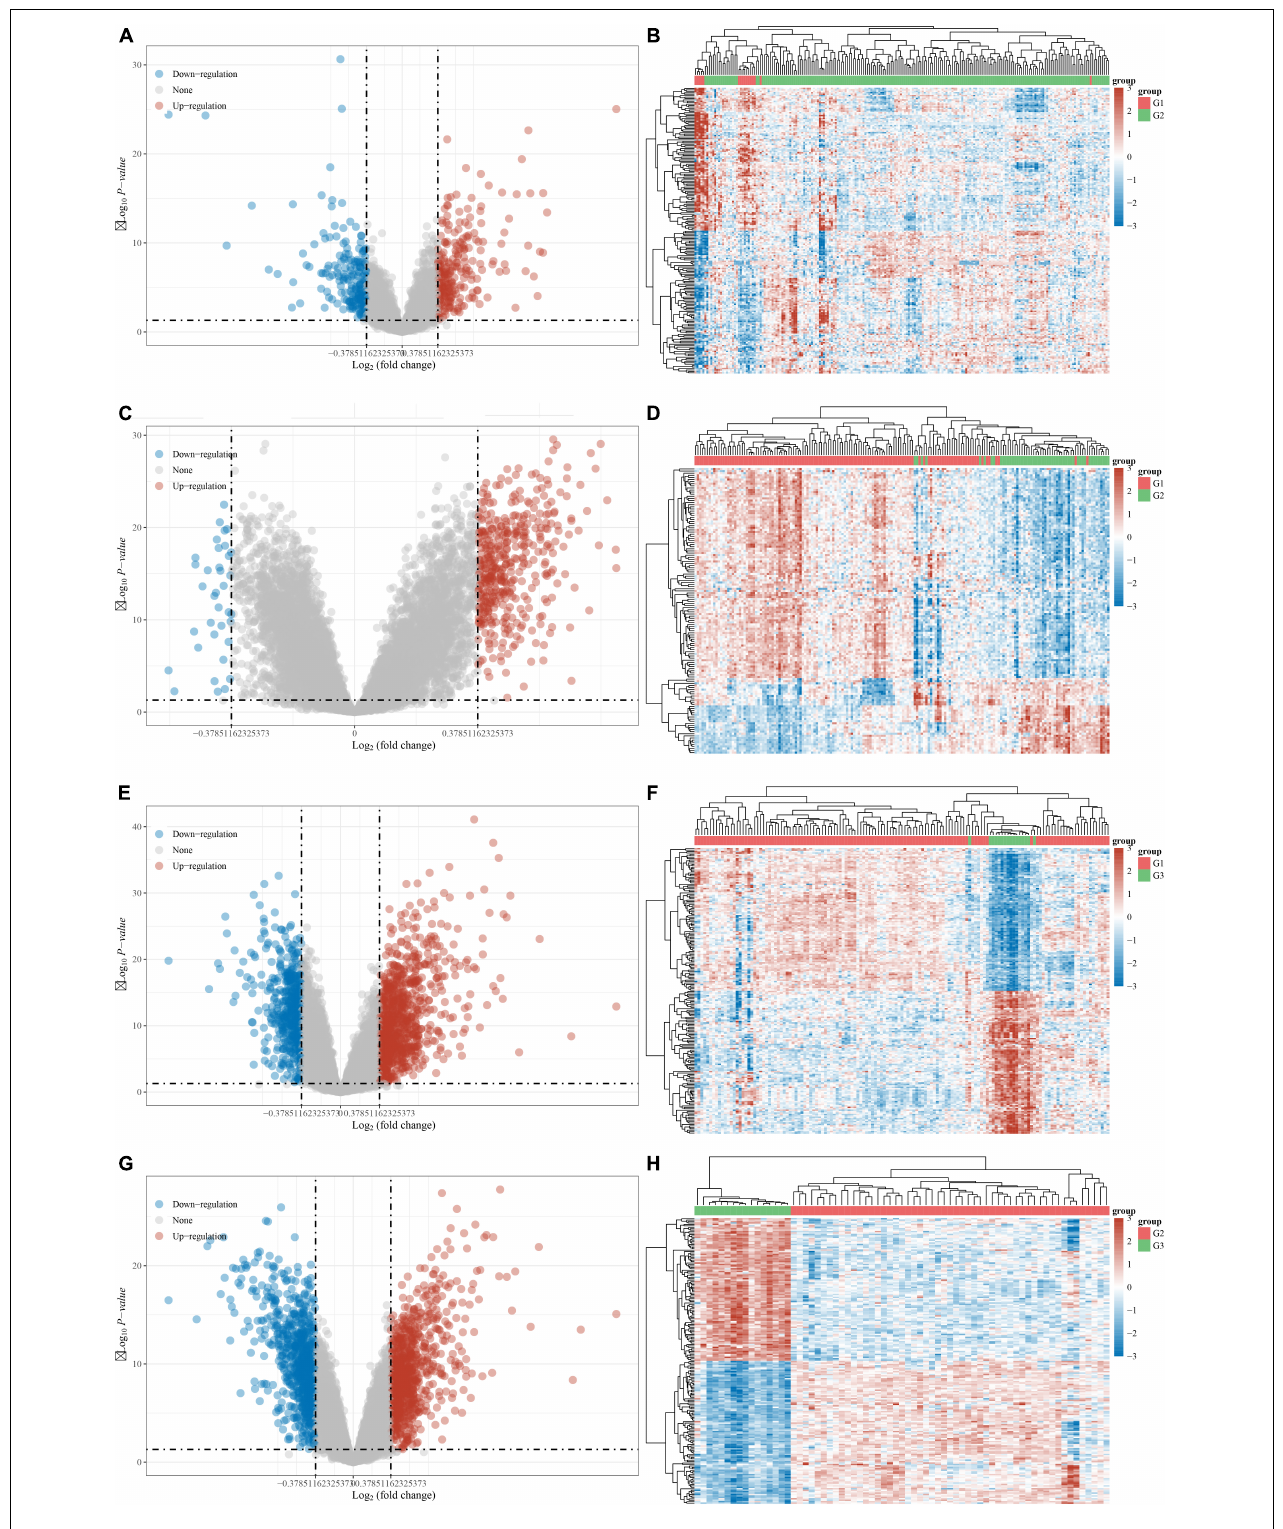
FIGURE 5 | Identification of DEGs between different clusters in MI. (A,B) Volcano plot and heatmap showed DEGs in MI compared with non-failing controls. (C,D) Volcano plot and heatmap showed DEGs in cluster 1 MI compared with cluster 2 MI samples. (E,F) Volcano plot and heatmap showed DEGs in cluster 1 MI compared with cluster 3 MI samples. (G,H) Volcano plot and heatmap showed DEGs in cluster 2 MI compared with cluster 3 MI samples.